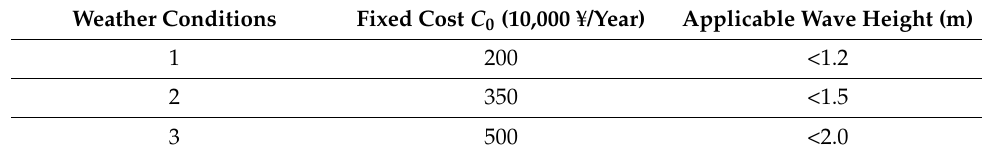
Table 4. Fixed maintenance costs under different weather conditions.